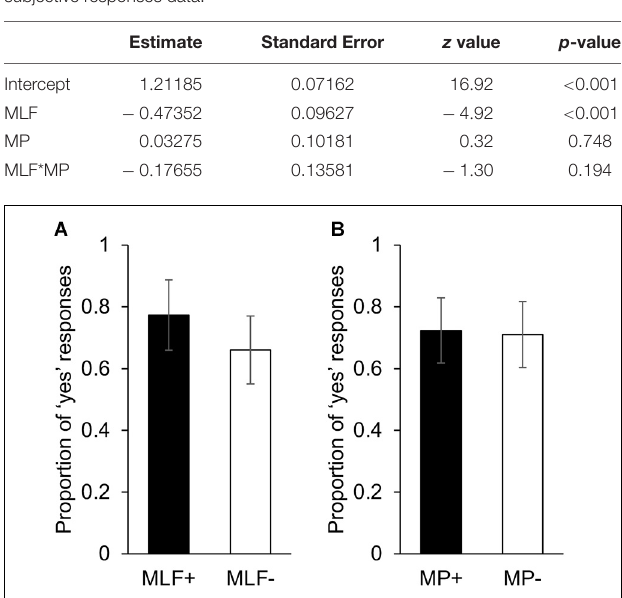
FIGURE 1 | (A) Yes response ratios in the Semantic Congruency task for sentences that adhered to (MLF+), and violated (MLF–), the predictions of MLF. (B) Yes response ratios in the Semantic Congruency task for sentences that adhered to (MP+), and violated (MP–), the predictions of MP. Error bars